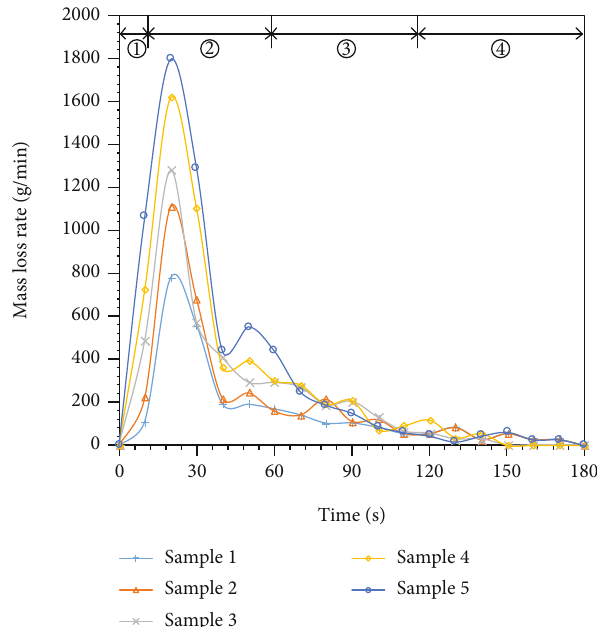
Figure 5: Evolution of mass loss rate during the erosion seepage.